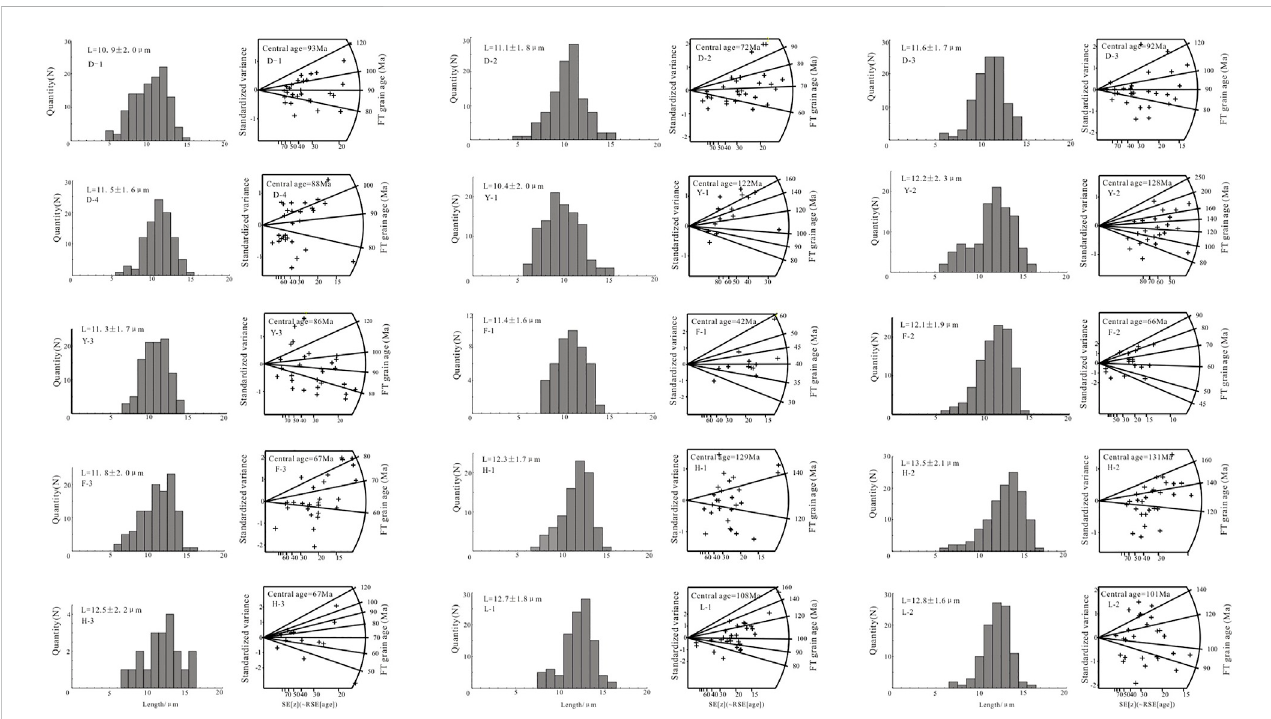
FIGURE 4 Fission track length histograms and radiograms of apatite grains from the northern Junggar Basin. The left panels of each group are fi ssion track length histograms, the right panels are fi ssion track radiograms, in which, X and Y -axes represent the age accuracy and standard deviations of single grains, respectively.